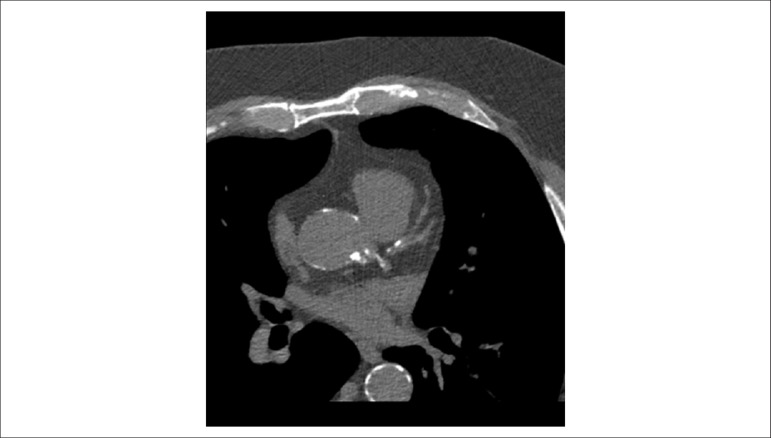
Case 3 - Angio-CT showing vascular calcifications involving coronary arteries and ascending and descending aorta.